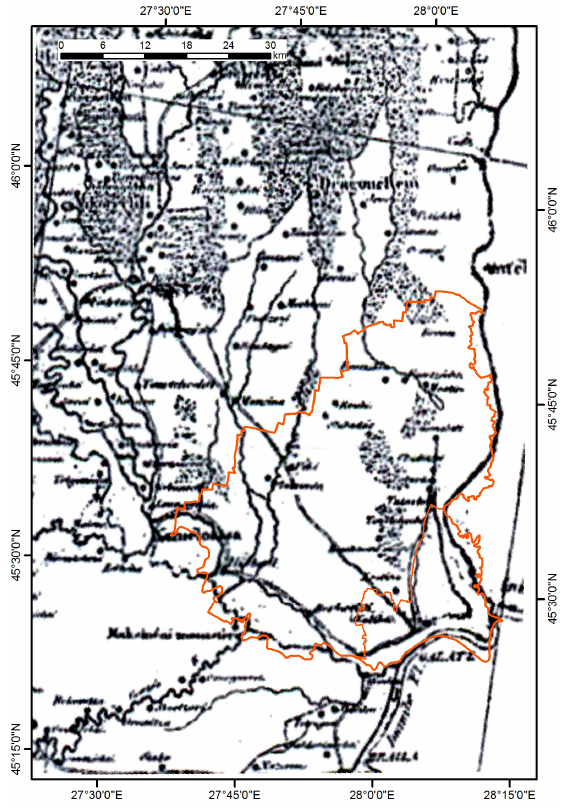
Figure 4. Forest bodies on Bergenheim ′ s map [63].